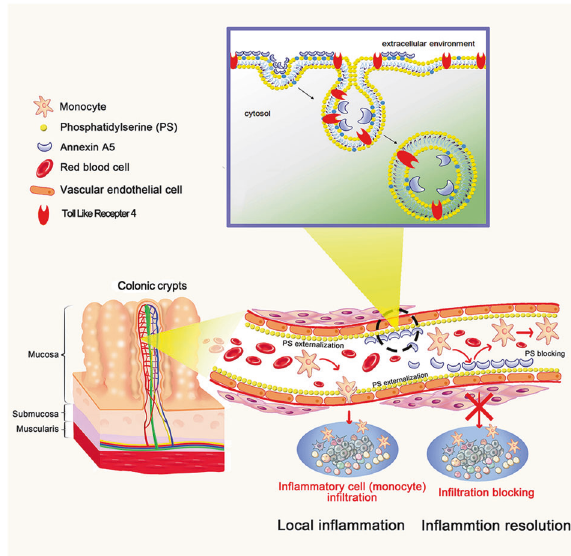
Fig. 8 The schematic diagram of therapeutic effects of ANXA5 in colitis. Externalized PS on the surface of colonic capillary lead to the targeted delivery of ANXA5 to colon. ANXA5 alleviates colitis by reducing in fl ammatory cell in fi ltration. Mechanistic investigations indicate that ANXA5 binds the exposed PS of activated HUVEC and inhibits its activation by triggering the internalization of TLR4 via a PS-dependent